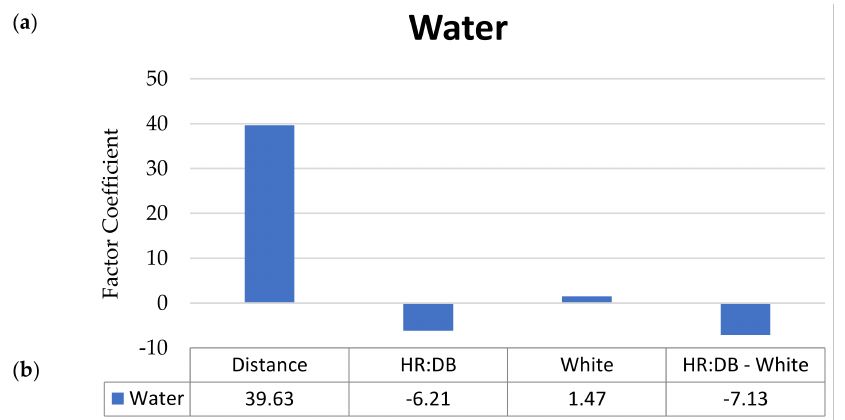
Figure 10. Effects sizes of the most relevant independent variable on the response water. ( a ) Graphical trend and ( b ) numerical coefficients (error bar = 0.05%, too small to be visible on the